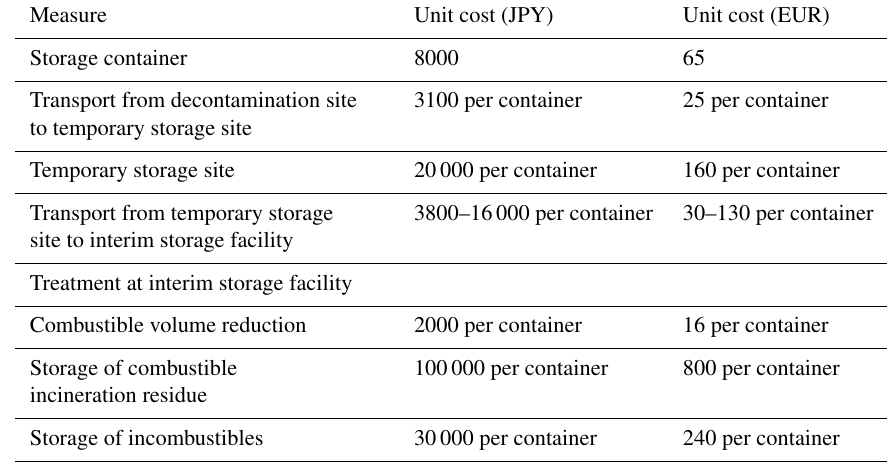
Table 3. Unit costs estimated for waste management and storage after Yasutaka and Naito (2016) in the